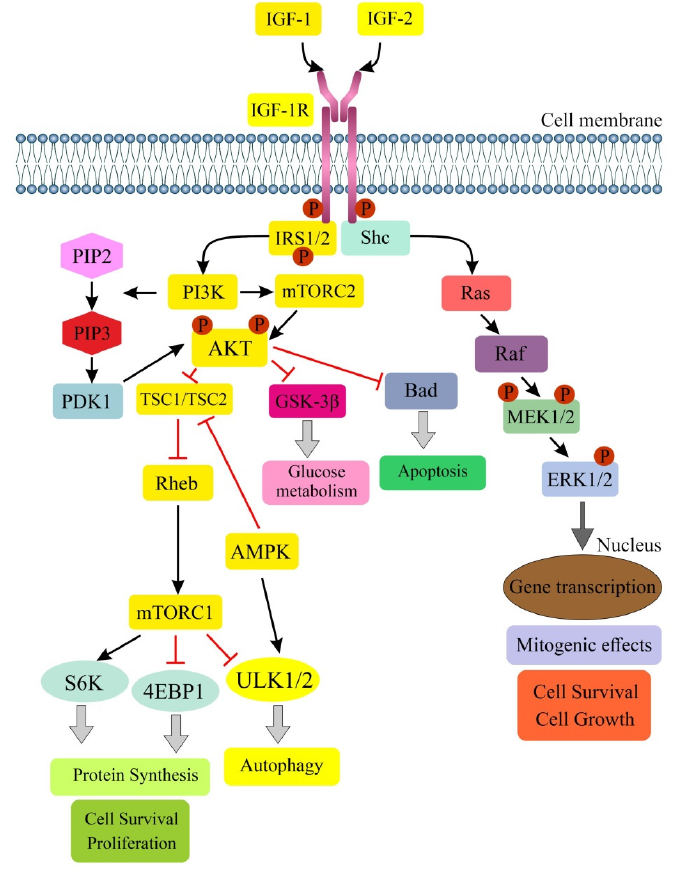
Figure 1. Schematic illustration of IGF/IGF-1R signaling pathway and its main downstream effectors. Stimulation of serine/threonine kinase AKT (named also PKB) activates mTORC1, leading to increase in protein synthesis. The Ras-Raf-ERK1/2 (MAPK) signaling is also activated to enhance mitogenic effects, cell survival and cell growth. IGF-1 binds mainly to IGF-1R, a typical tyrosine kinase membrane receptor and exerts growth-promoting, anti-apoptotic effects. Initial phosphorylation targets for IGF-1R include IRS 1/2, and among the downstream signaling effectors are PI3K, AKT, mTOR, S6K and Ras-ERK 1/2 (MAPK) pathway components. PI3K kinase, which has two subunits, p85 and p110, in turn phosphorylates a lipid protein, PIP2 to PIP3. PIP3 signals’ proteins such as PDK1 activate AKT by acting on its serine and threonine residues. Activated AKT inhibits GSK-3 β and TSC1/TSC2 via phosphorylation. Inactive TSC1/TSC2 is unable to bind Rheb, which subsequently enables the activation of mTORC1 at the surface of lysosome, initiating its effect on S6K, 4EBP1 and ULK1/2, which are responsible for protein synthesis, cell survival, proliferation, delayed apoptosis and inhibition of autophagy. A potential stimulator of autophagy is AMPK signaling. The yellow boxes show the key components of IGF/IGF-1R and AMPK signaling in the regulation of autophagy, the details of which are discussed in the text. Legend: → : lead to; Ʇ : inhibits; AKT (PKB): serine/threonine kinase (protein kinase B); AMPK-5 ′ adenosine-monophosphate-activated protein kinase; Bad: Bcl-2 associated agonist of cell death; 4EBP1: eukaryotic translation initiation factor-binding protein 4E; GSK-3 β : glycogen synthase kinase-3 β ; IGF: insulin-like growth factor; IGF-1R: IGF receptor type 1; IRS1/2: insulin-receptor substrate 1/2; MAPK: mitogen-activated protein kinase; mTORC1/2: mammalian target of rapamycin complex 1/2; PDK1-3: phosphoinositide-dependent protein kinase 1; PI3K: phosphatidylinositol-3-kinase; PIP2: phosphatidylinositol-4, 5-biphosphate; PIP3: phosphatidylinositol-3,4,5-triphosphate; Rheb: Ras homolog enriched in brain; shc: adaptor protein; S6K: S6 kinase; TSC1/2: tuberous sclerosis complex 1/2; ULK1/2: Unc-51-like autophagy activating kinase